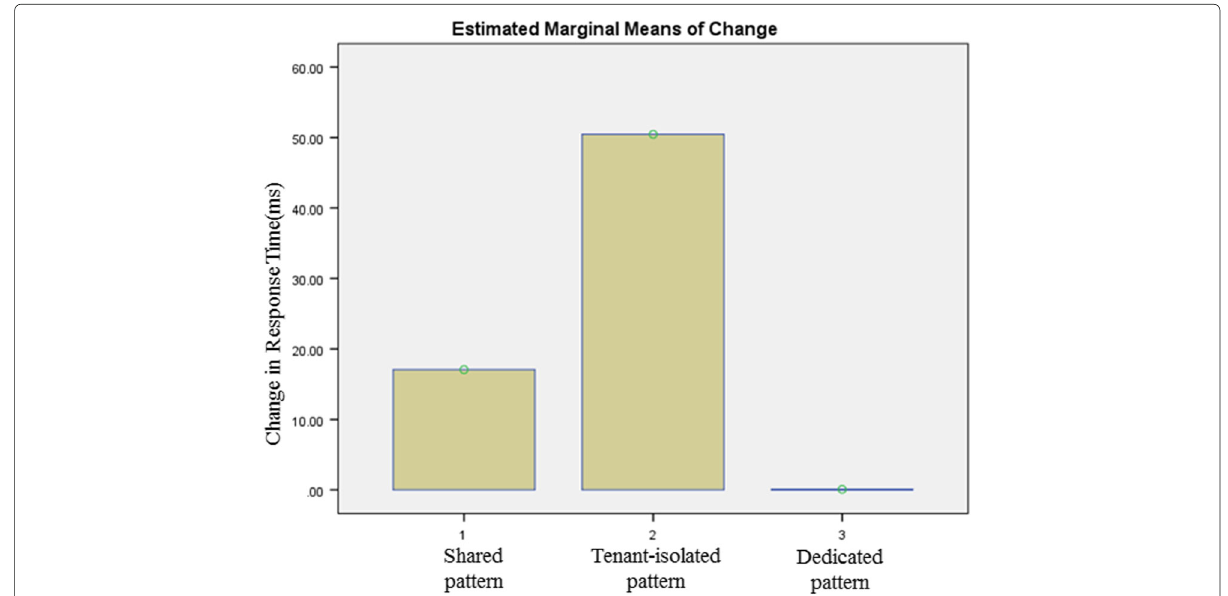
Fig. 22 Changes in Response Times